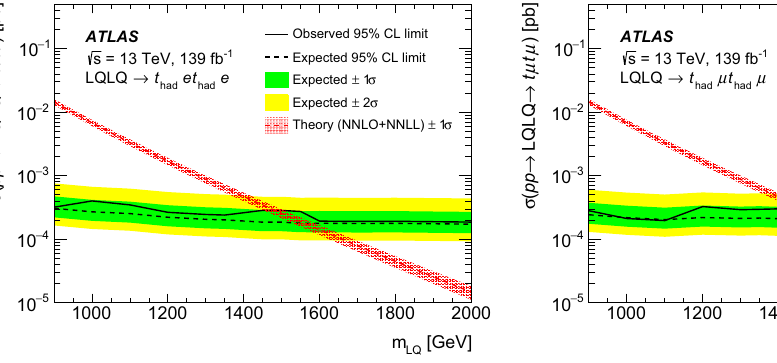
Fig. 5 Upper limits at 95% CL on the cross section of LQ pair production as a function of LQ mass, assuming a branching ratio B ( LQ → t (cid:5) ± ) = 1, for the electron (left) and muon (right) chan- nel. Observed limits are shown as a black solid line and expected limits